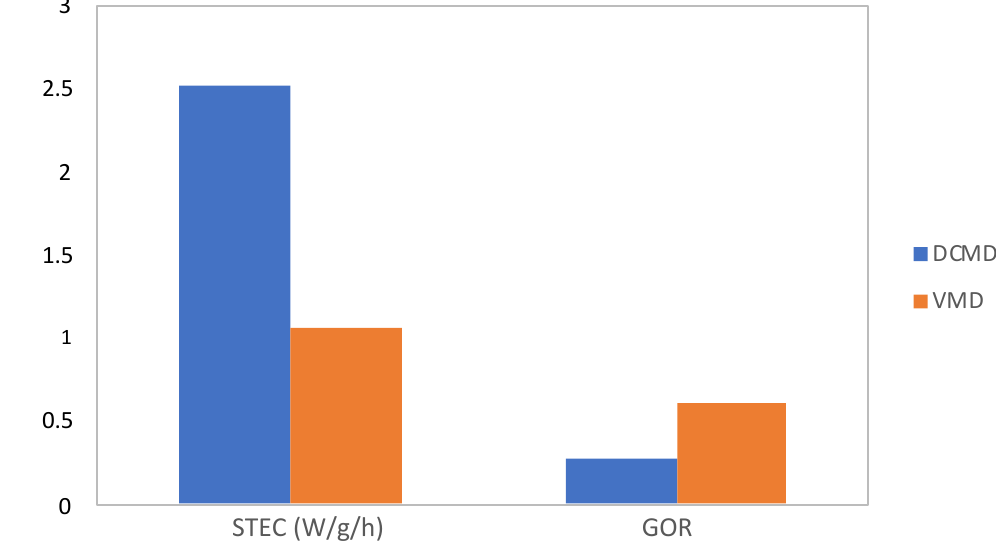
Figure 8. STEC and GOR of the two MD units, considering for both the experimental feed temperature decay of the DCMD unit (0.3 °C).